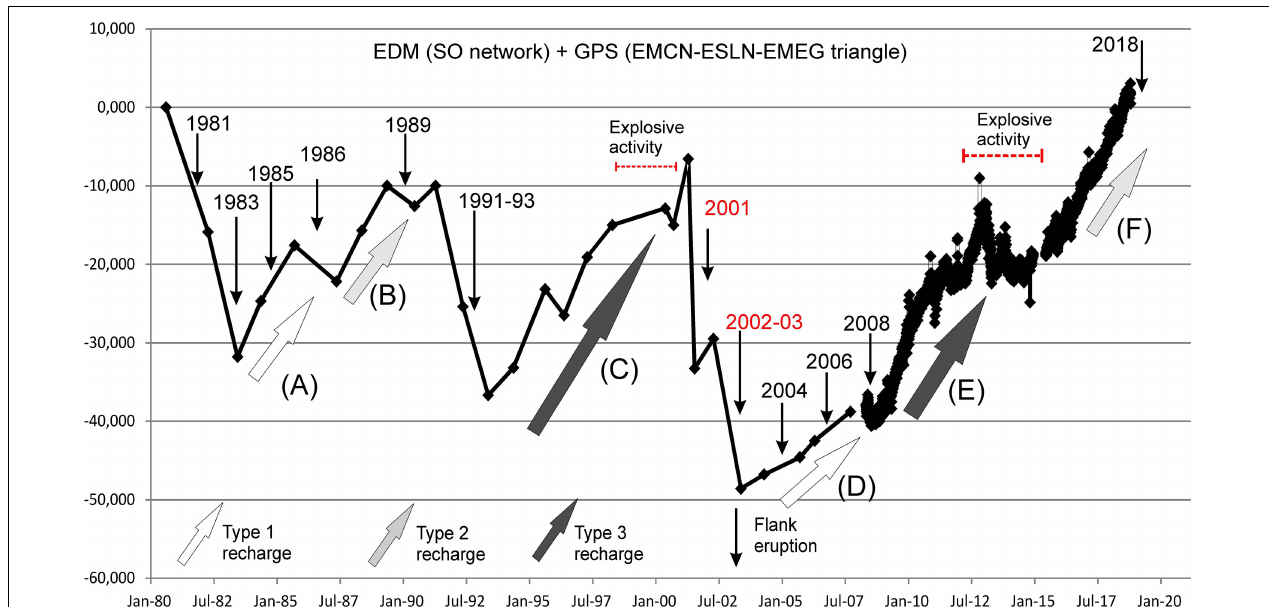
FIGURE 4 | Areal dilatation (ppm) of the EDM network in the western flank from 1980 to 2007 comprising the recharge phases from A to D, and the dilatation from the CGPS triangle GPS EMCN-ESLN-EMEG from 2007 to 2018 comprising the recharge phases E and F (see Table 2 ). (A) 1983–1987. Recharge phase accompanied by close effusive eruptions and eastern flank marked sliding (inflation type 1). (B) 1987–1991. Long-term recharge phase before the main effusive 1991–1993 eruption (inflation type 2). (C) 1994–2001. Long-term recharge phase preceding the two main effusive-explosive 2001 and 2002–2003 eruptions (inflation type 3). During C1–C3 (1993–1997) a marked source deepening is inferred. (D) Recharge phase accompanied by close effusive eruptions and eastern flank marked sliding (inflation type 1). (E) Recharge phase preceding the 2011–2015 explosive activity (inflation type 3). (F) Recharge phase preceding the December 2018 brief eruption (inflation type